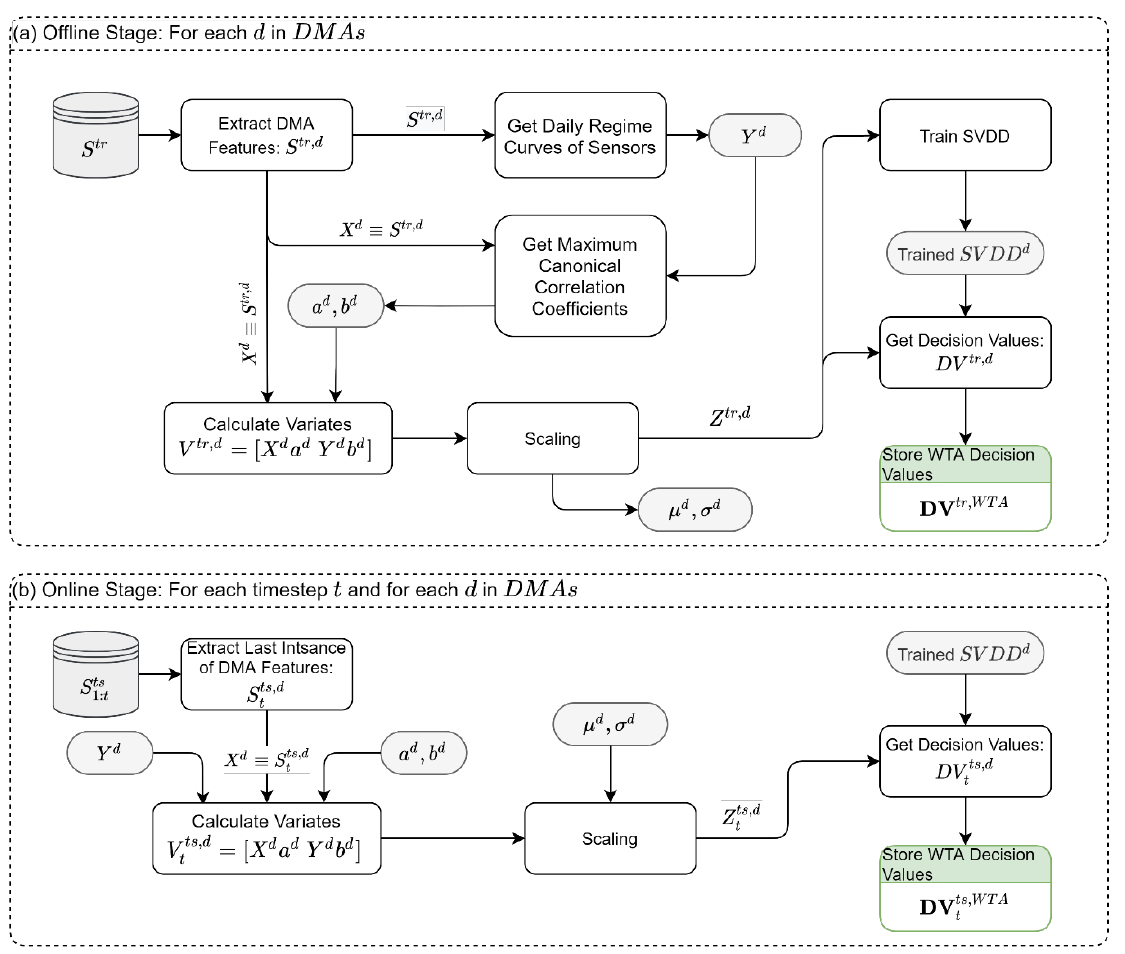
Figure 3. Within-DMA temporal analysis module: ( a ) Offline Stage, ( b ) Online Stage. Notes: Gray shade is the data created in the Offline Stage and used in the Online Stage; green shade is the data used in the synthesis module.